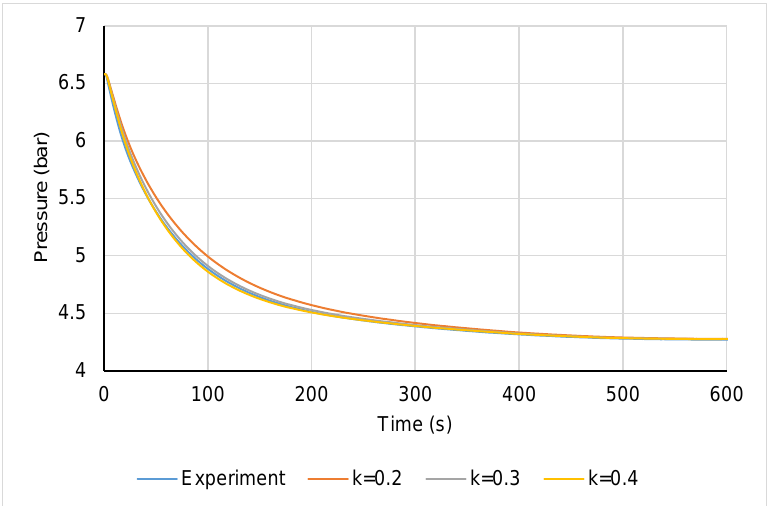
Figure 12. Pressure change during the LTJ adsorption test and comparison to model with carbon conductivity of 0.2, 0.3, and 0.4 W m −1 K −1 (300-mm module).